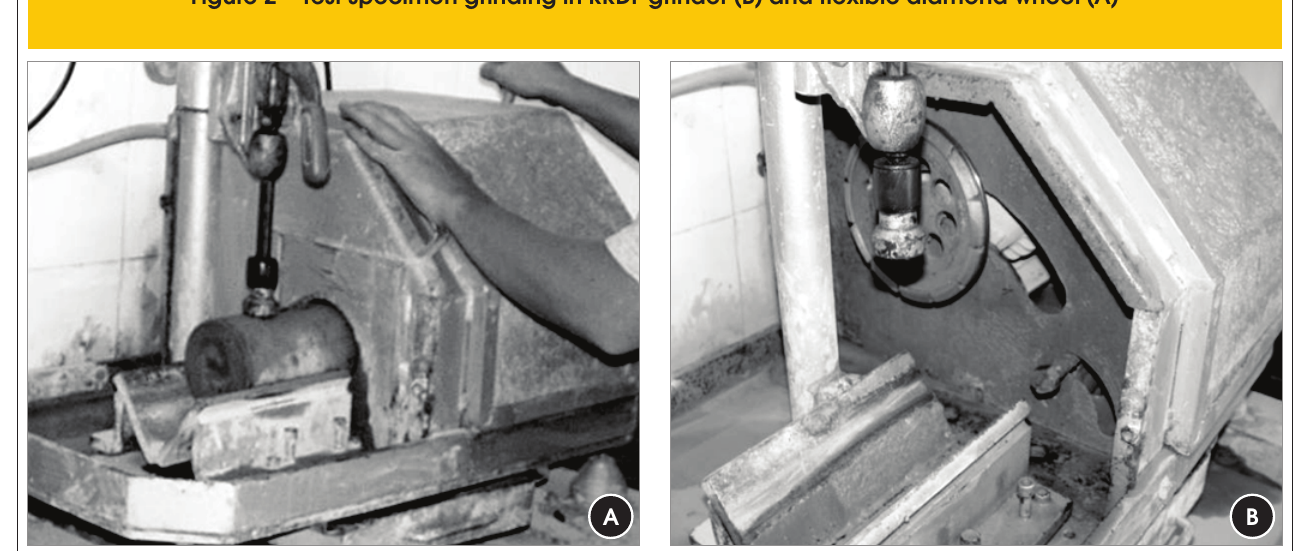
Figure 2 – Test specimen grinding in RRDF grinder (B) and flexible diamond wheel (A)